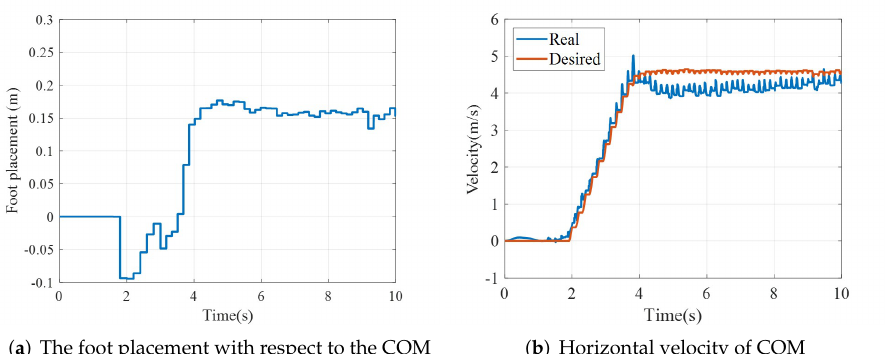
Figure 7. Simulation result when the target speed is 4.5 m/s. The angular motion of the upper body was generated based on momentum control.